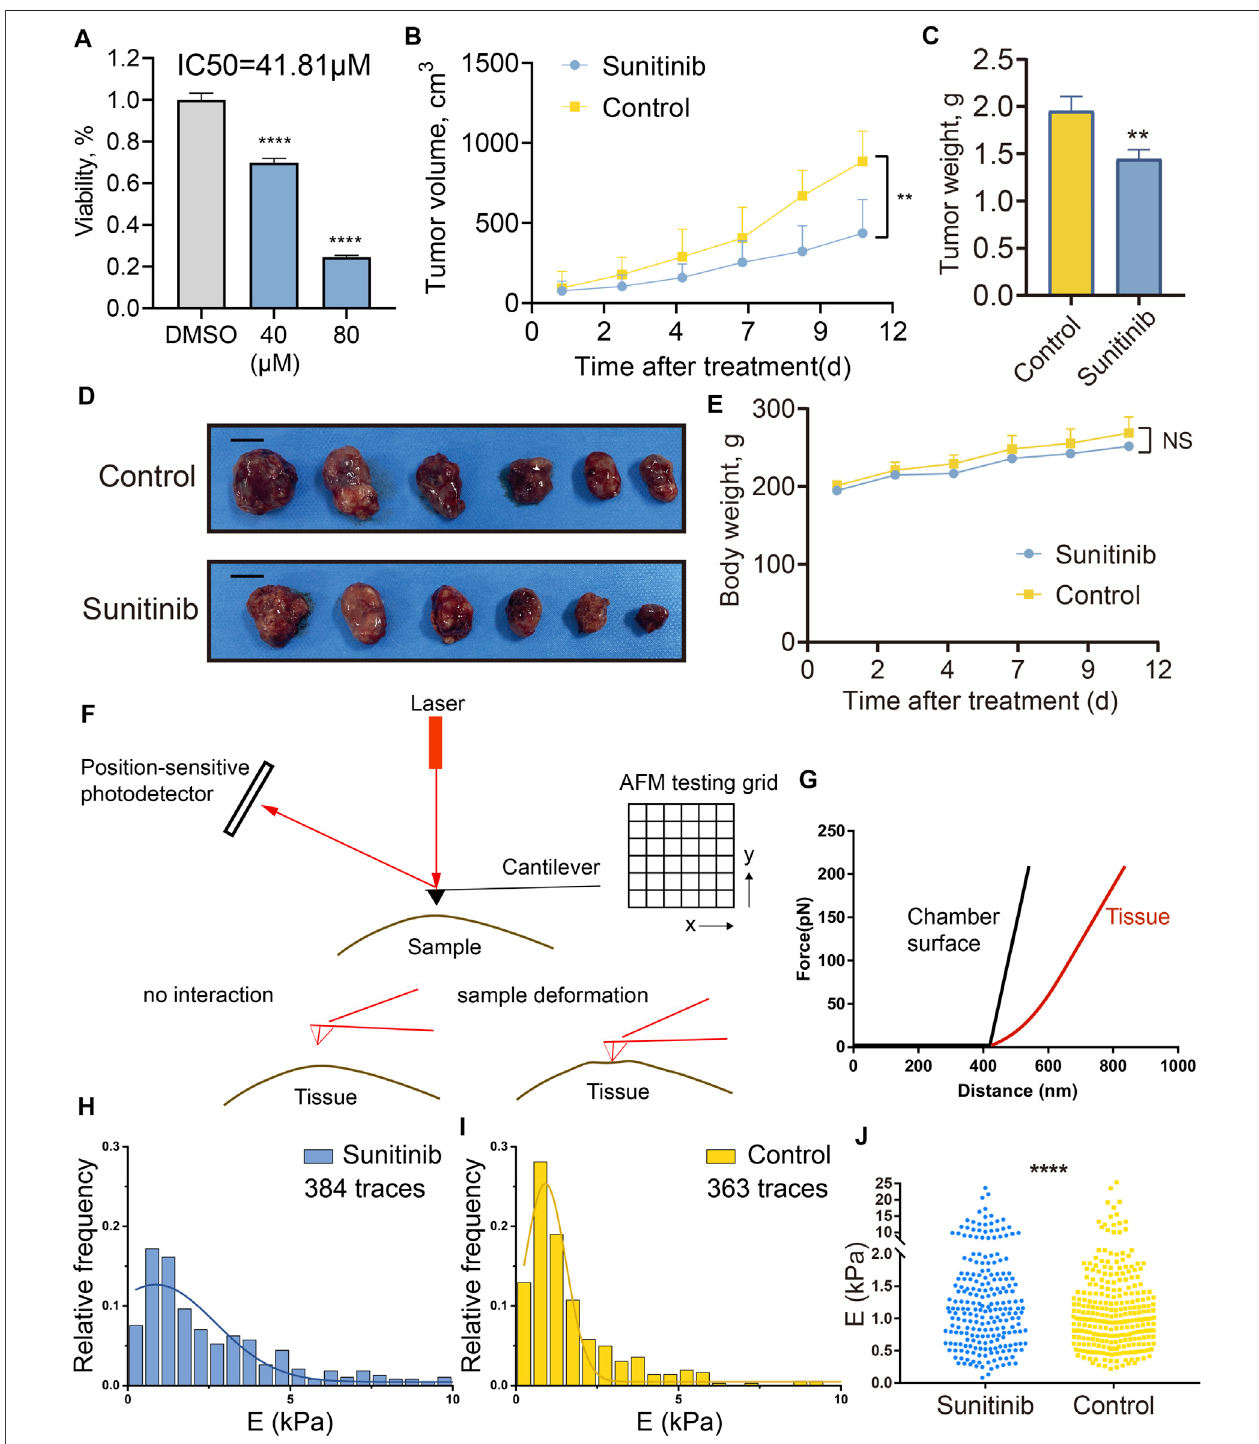
FIGURE 8 | Sunitinib inhibited PA growth in vitro and in vivo , and reduced tumor stiffness in xenograft PA models examined by AFM. (A) Cell viability of GH3 cells treated with sunitinib or DMSO for 2 days. Three independent experiments were repeated for each result. *** means p < 0.001. Bar represents mean ± SD. (B) Tumor volumeofratstreatedwithsunitinib orvehicle control oncedaily,measured for12 days. (C) Tumorweight ofratstreatedwith sunitinib orvehicle control. **means p < 0. 01. (D) Macroscopic image of the resected tumors. Scale bar: 1 cm. (E) Body weight of rats measured for 12 days “ NS ” means no signi fi cant difference between groups. (F) WorkingschematicoftheAFMsetupusedformechanicalpropertymeasurementoftumorsamples. (G) SlopechangesdeliverYoung ’ smoduluschangesof differentinteractionsurfaces.Blackcurverepresentsforcevs.distancecurverecordedforthechambersurface(reference),andtheredonerepresentsforcevs.distance